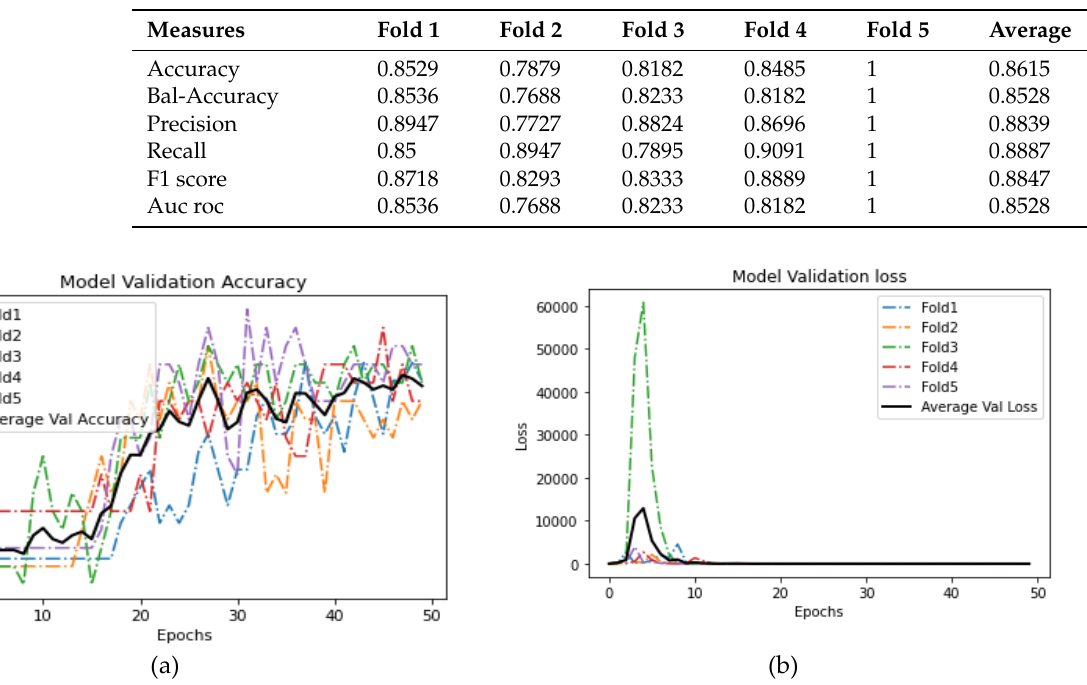
Table 4. K-folds performance results using ResNet50V2.